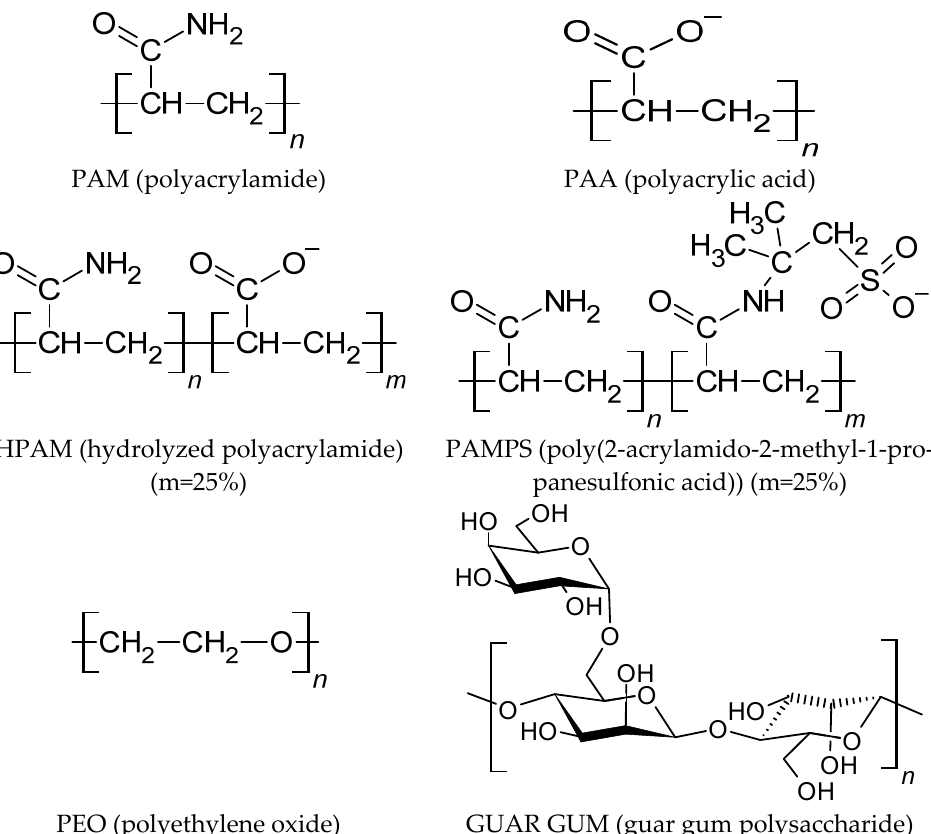
Figure 1. Monomer structure of the molecules studied in this work.